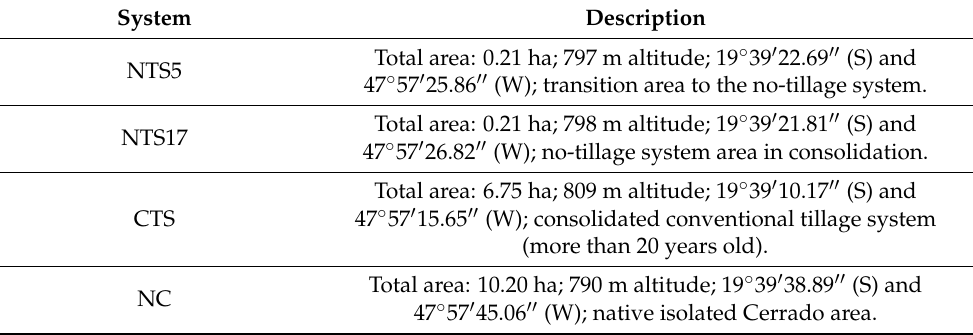
Table 1. Historic description and location of the study areas.